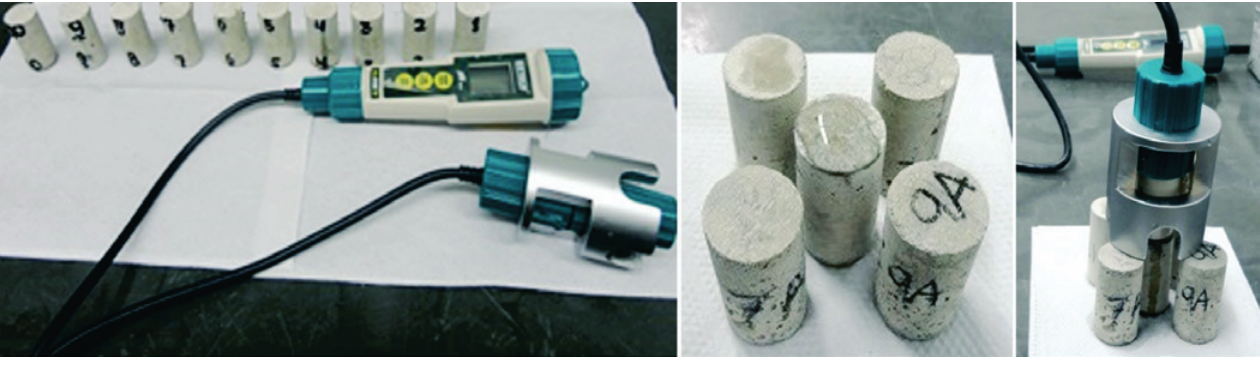
pH measurement of one (2 x 4) cm